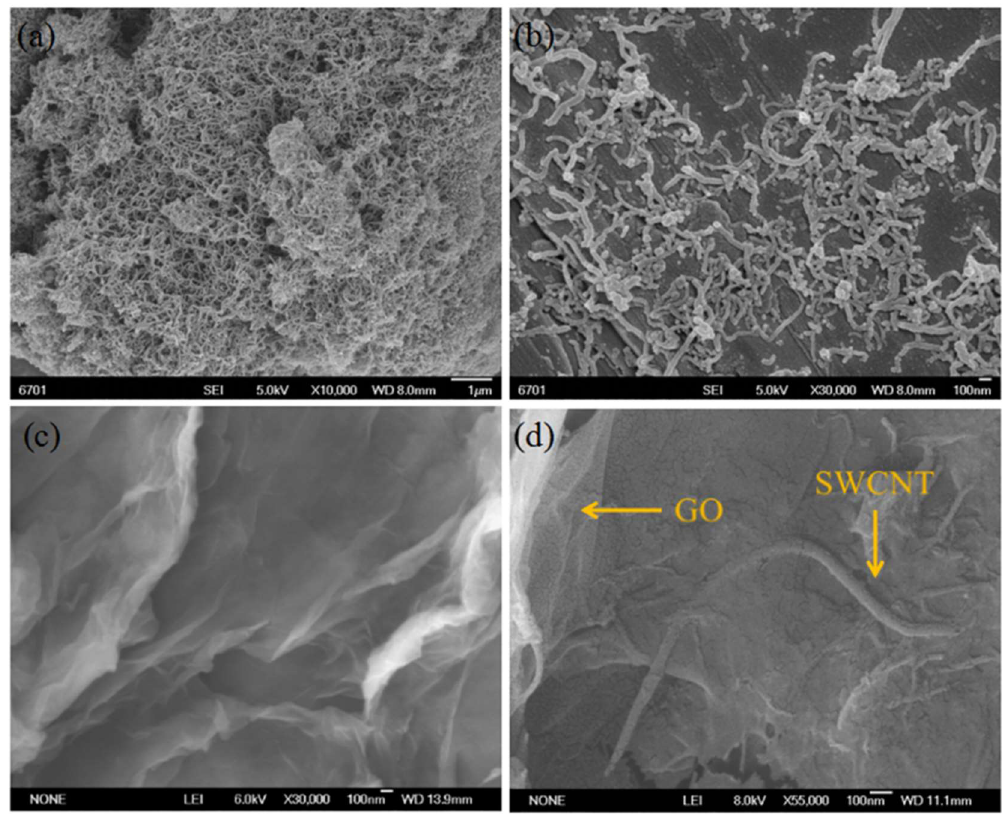
Figure 3. The SEM images of ( a ) original SWCNTs, ( b ) purify SWCNTs, ( c ) GO, ( d ) GO/SWCNTs.